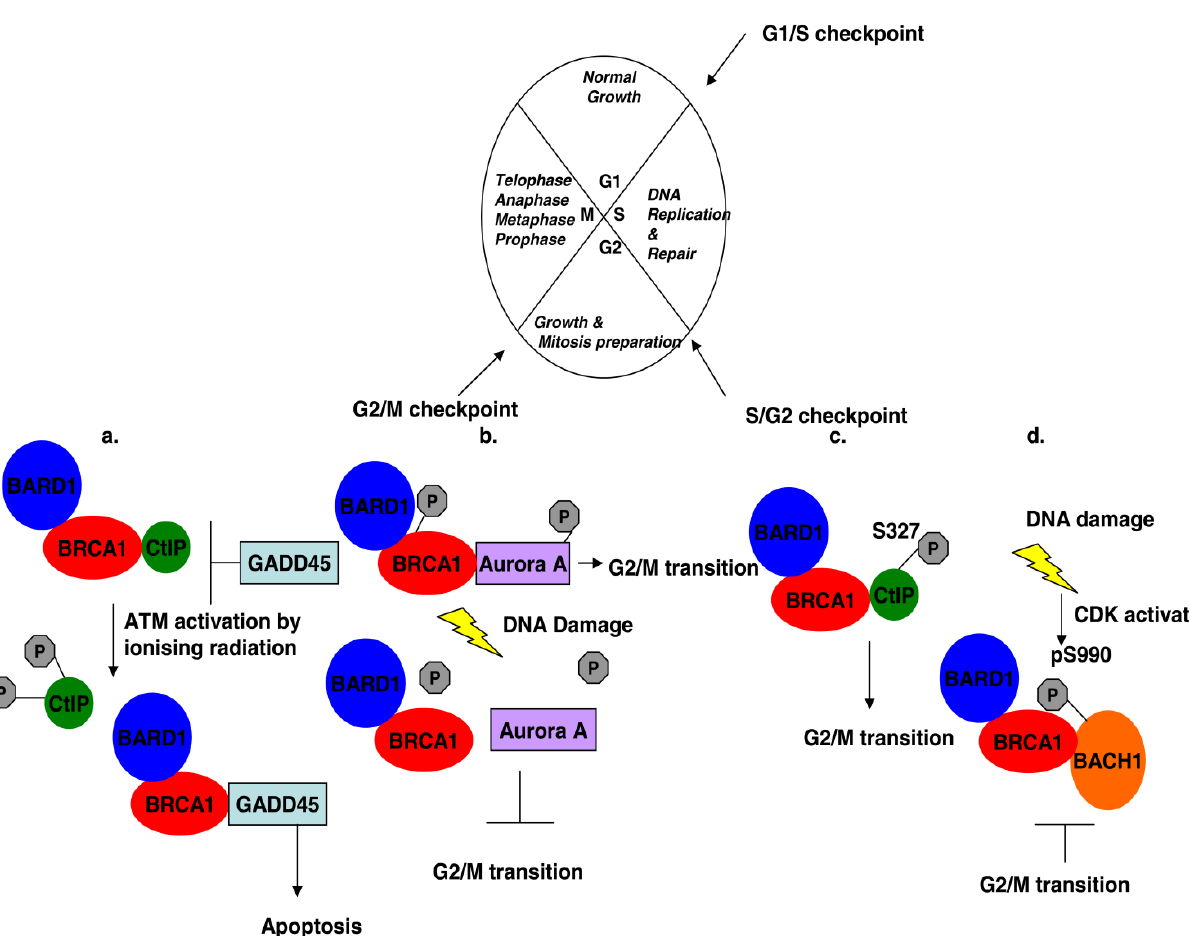
Figure 2. Cell cycle regulation mediated by BRCA1 and its associated proteins. ( a ) G2/M transition: Ionizing radiation induces phosphorylation of CtIP at residues S664 and 745, causing its dissociation from BRCA1, which represses GADD45 activation. Free BRCA1 activates GADD45 and downstream signaling leads to cell death by apoptosis instead of entering into mitosis. ( b ) The interaction of phosphorylated BRCA1 at serine residue 308 with phosphorylated Aurora A kinase regulates G2/M transition. DNA damage dephosphorylates both proteins and the complex dissociates with the effect that the cell gets stalled in the G2 phase. ( c ) BRCA1 controls transiently the G2/M transition through its interaction with phosphorylated CtIP at serine 327. ( d ) DNA damage activates Cyclin-dependent kinases in the G2 phase of the cell cycle, which phosphorylates BACH1 thus promoting the interaction with BRCA1 and cells accumulate in the G2